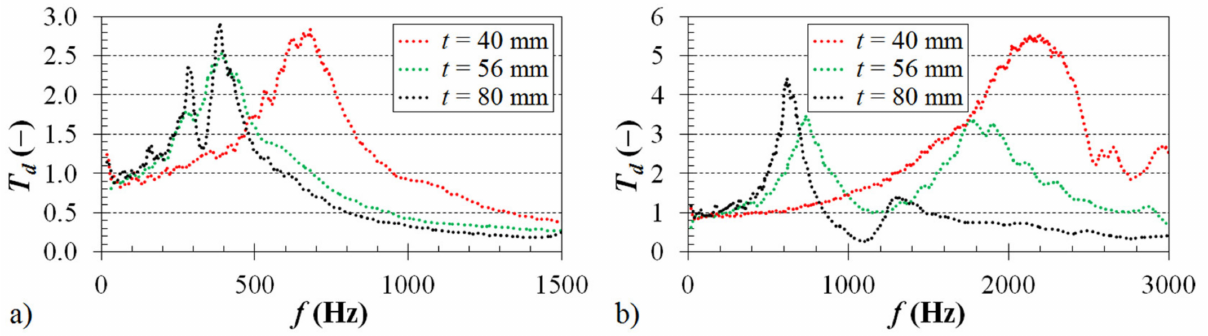
Figure 8. Influence of the material thickness on the displacement transmissibility: ( a ) inertial mass m i = 90 g, volume ratio V r = 45%; ( b ) inertial mass m i = 0 g, volume ratio V r =